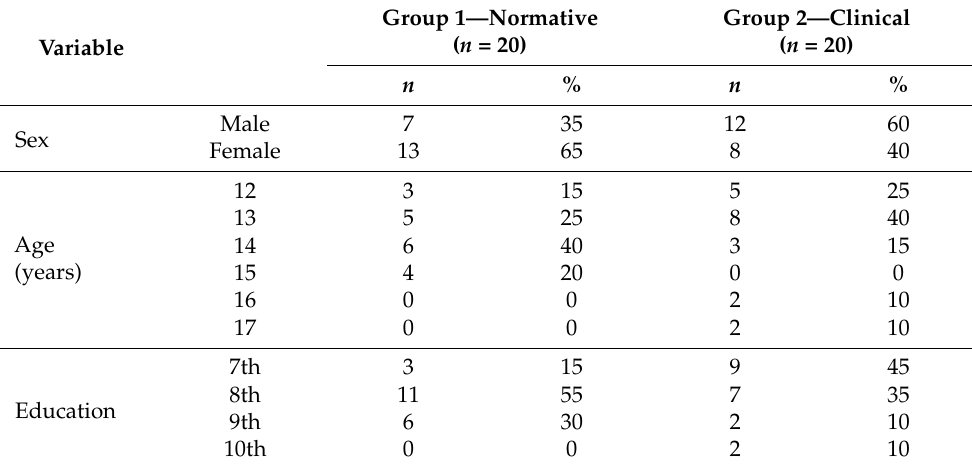
Table 1. Sociodemographic characteristics of the sample ( n =